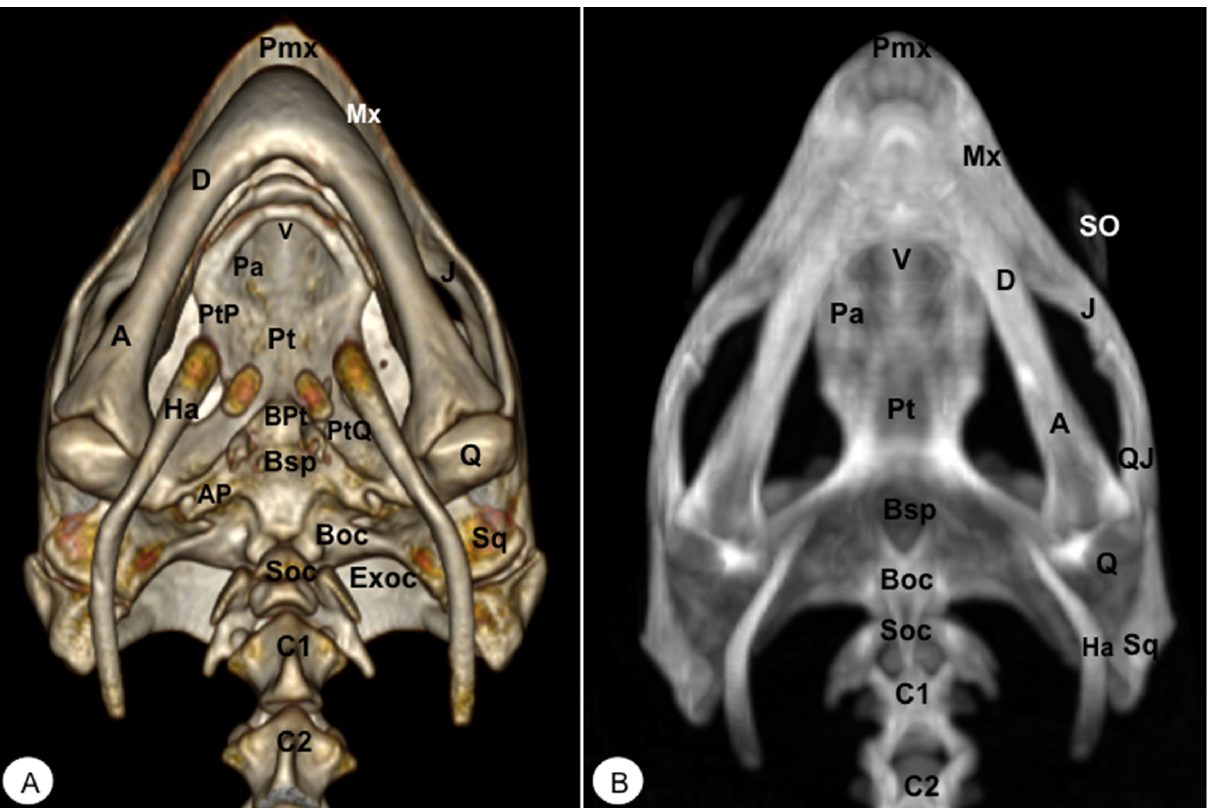
Figure 4. Head of Caretta caretta . ( A ) Ventral VR image. ( B ) Ventral MIP image. Pmx: Premaxillary bone. Mx: Maxillary bone. J: Jugal. V: Vomer. Pa: Palatine. PtP: Pterygoid palatine process. BPt: Ba- sipterygoid. Pt: Pterygoid. PtQ: Pterygoid quadrate process. SO: Scleral ossifications. Sq: Squamosal. Q: Quadrate. QJ: Quadratojugal. Bsp: Basisphenoid. AP: Articular process of Bsp. Boc: Basioccipital. Soc: Supraoccipital. Exoc: Exoccipital. M: Mandible. D: Dentary. A: Angular. Ha: Hyoid apparatus. C1: First cervical vertebra. C2: Second cervical vertebra.